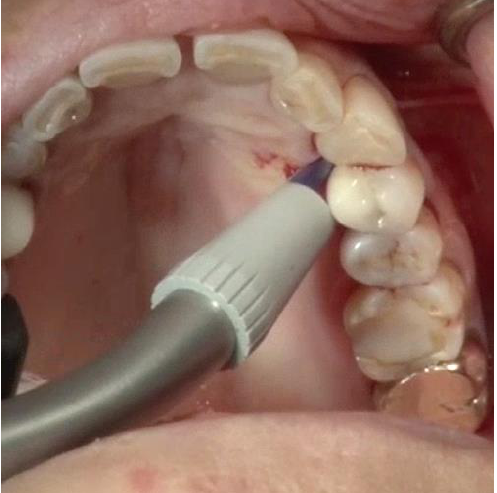
Figure 6. The tip of the retractor on the videoscope is rotated to an optimal angle and used to gently push back the lingual flap to allow visualization of the bone loss.